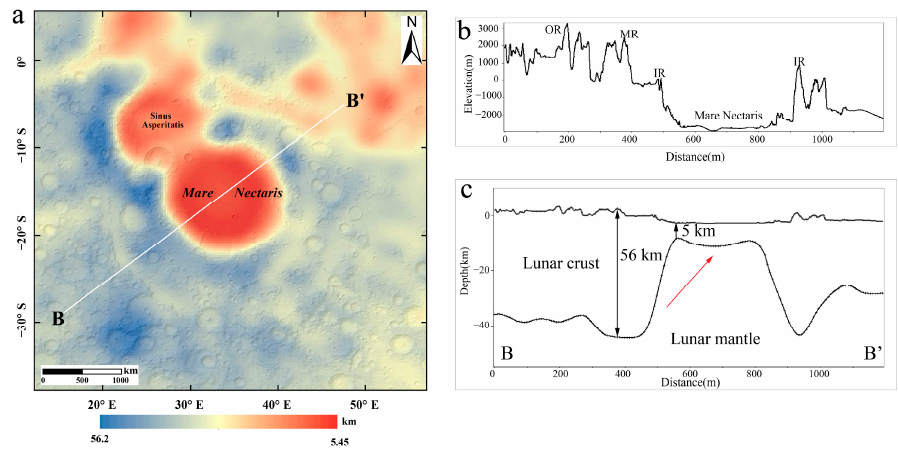
Figure 6. ( a ) Crustal thickness map of the Nectaris Basin with shaded relief topography; ( b ) topo- graphic profile from B to B’ based on SLDEM, IR means Inner Ring, MR means Middle Ring, OR means Outer Ring; ( c ) subsurface characteristics of the Nectaris Basin along the AA’ profile.